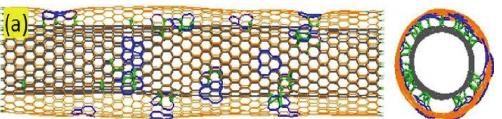
Figure 7: Side and axial view of a (17, 0)/(26, 0) DWCNT with 20 vacancy defects